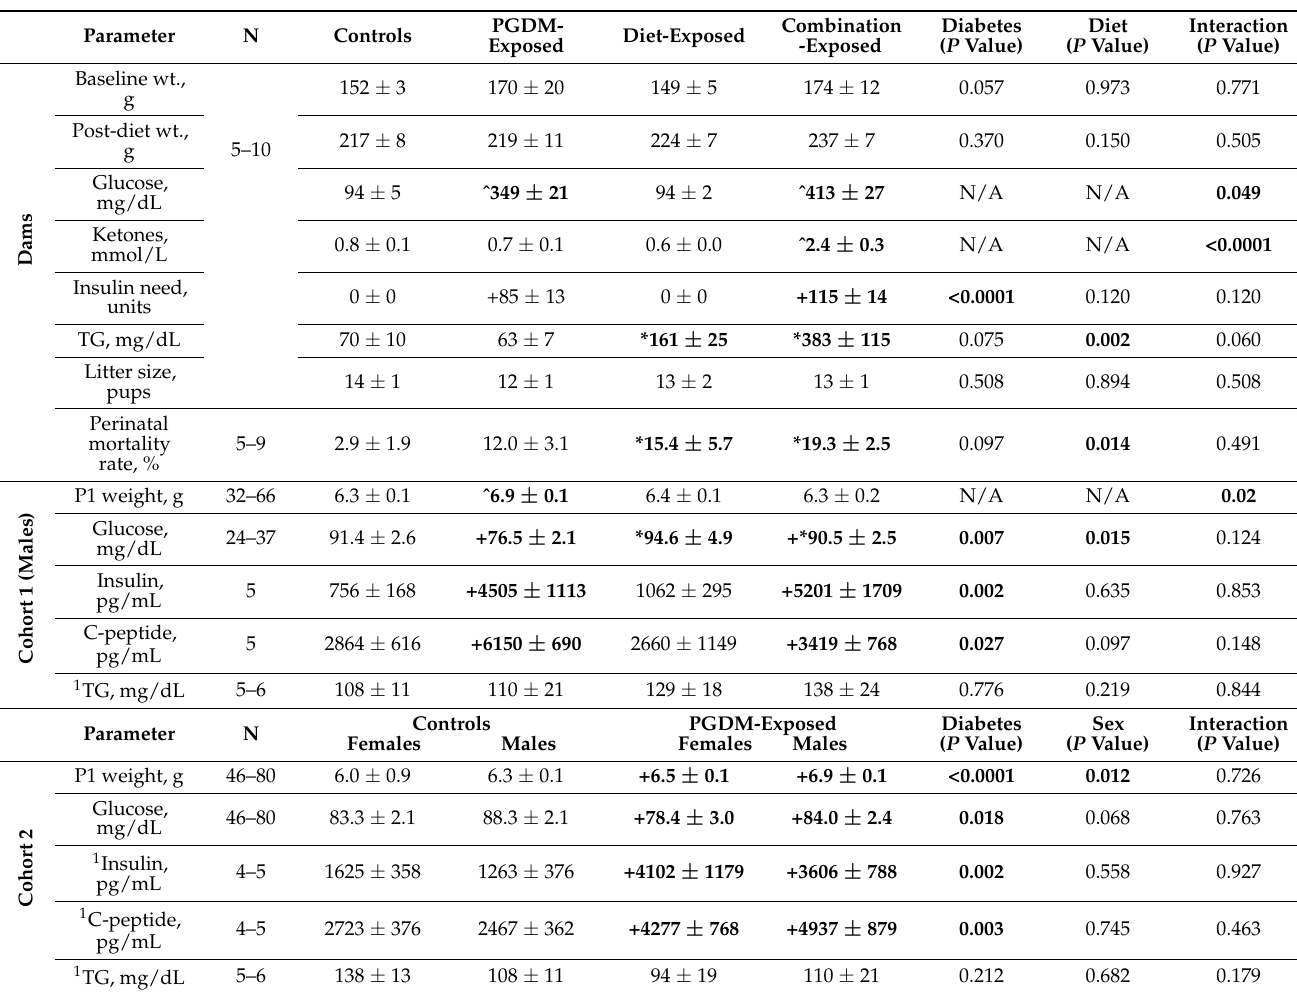
Table 1. Maternal and offspring characteristics.